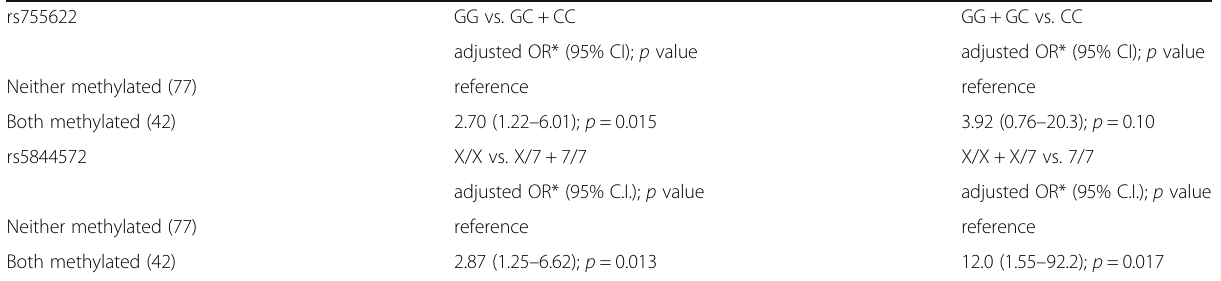
Table 6 Association between MIF polymorphisms and CDKN2A methylation rs755622